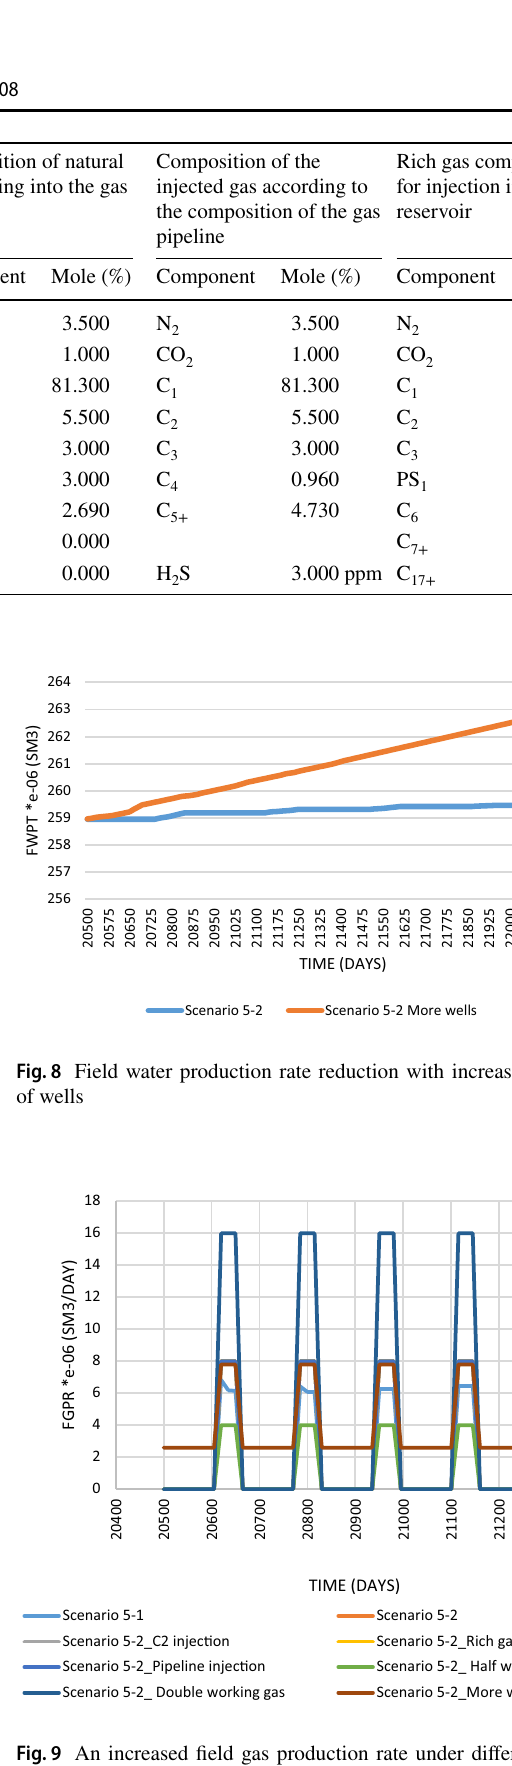
Fig. 9 An increased field gas production rate under different scenar-